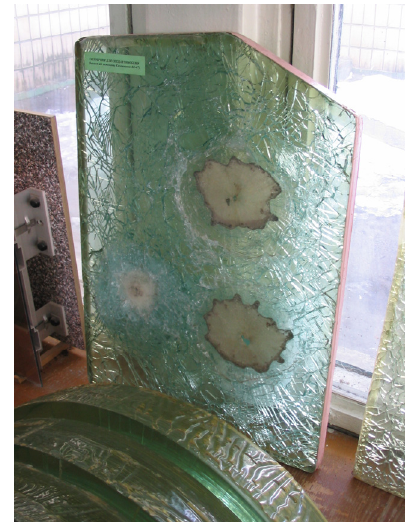
Figure 2. The multilayer bulletproof glass and composite rings made of sheet glass